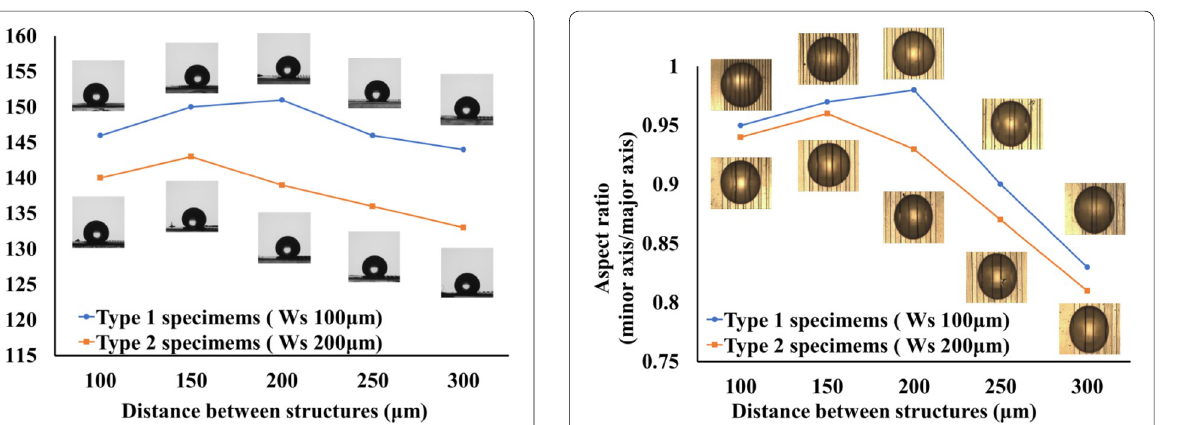
Fig. 5 A plot of static CAs of Type 1 and Type 2 specimens versus distance between the parallelogram structures